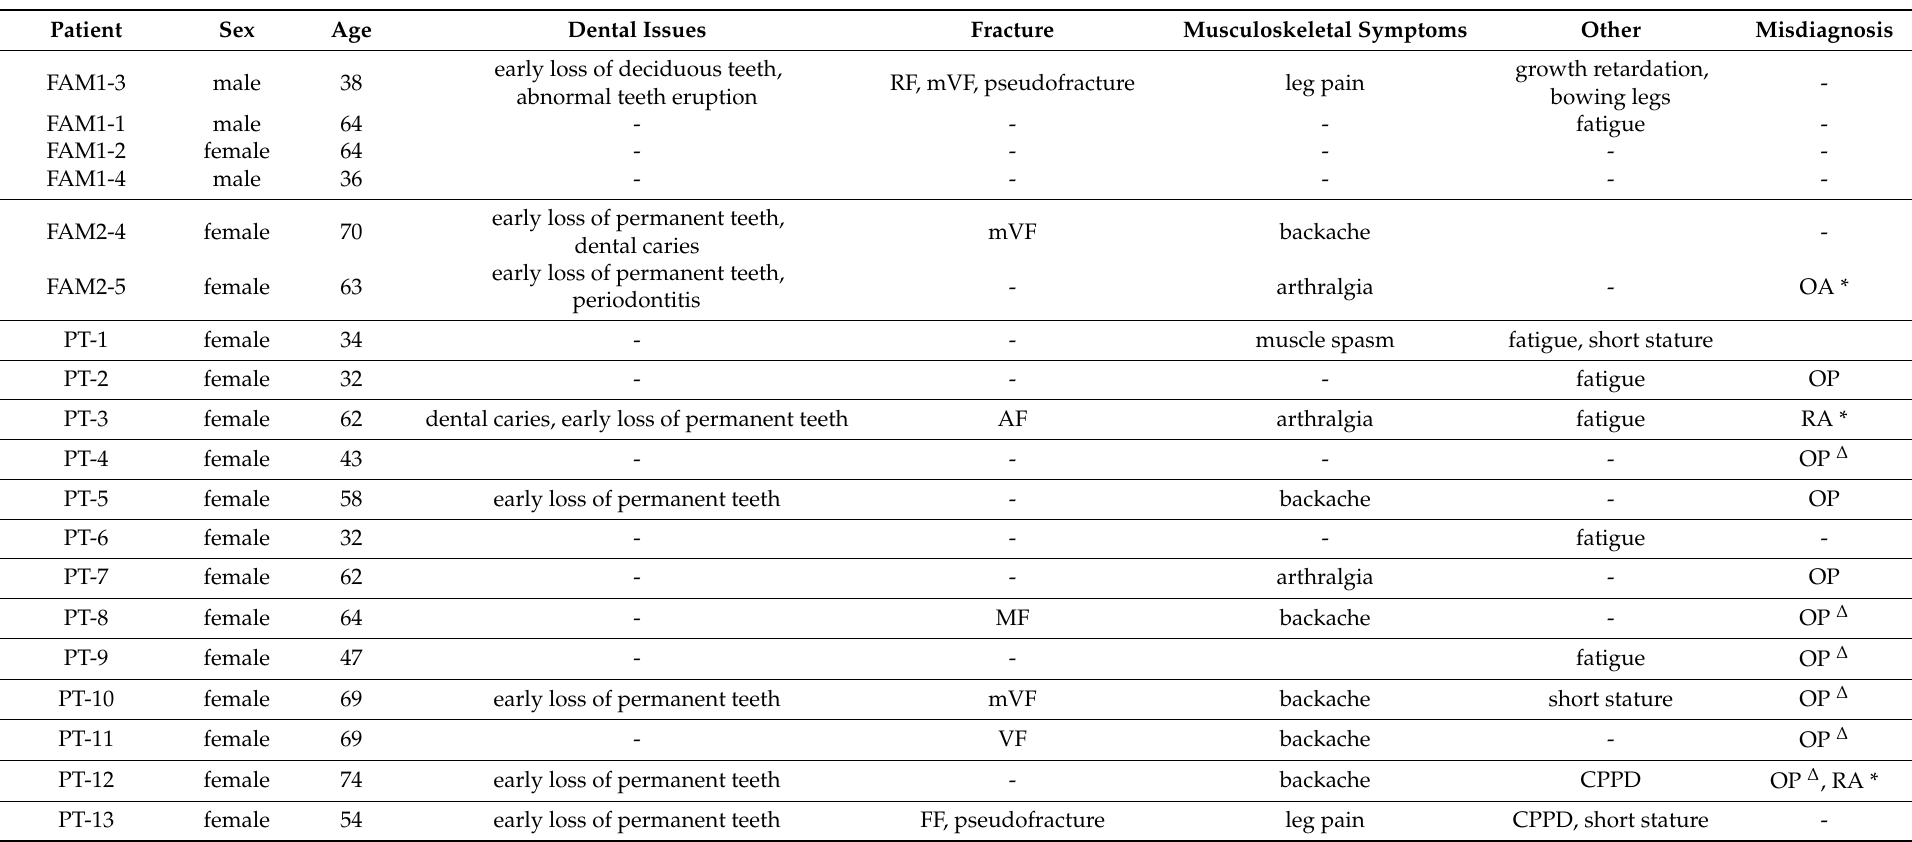
Table 1. Clinical